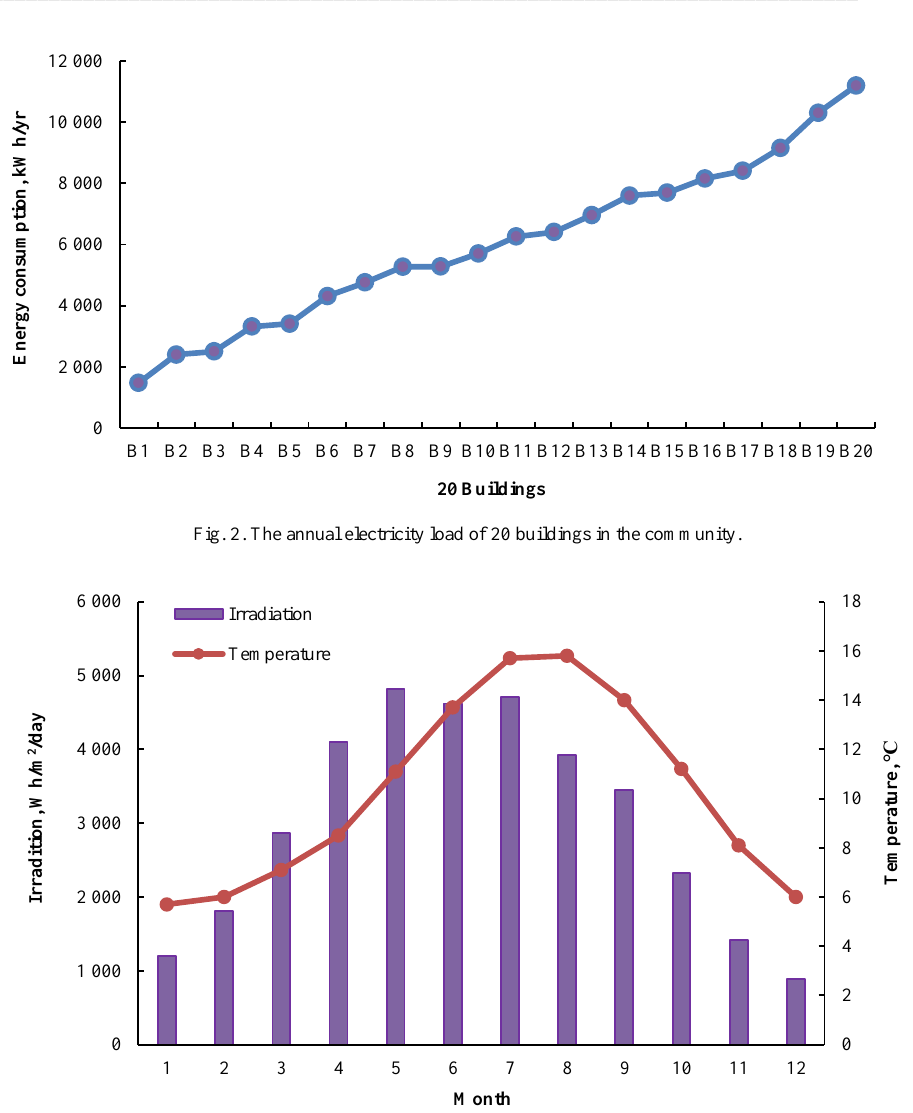
Fig. 3. Average temperature and irradiation on optimally inclined plate in Ireland